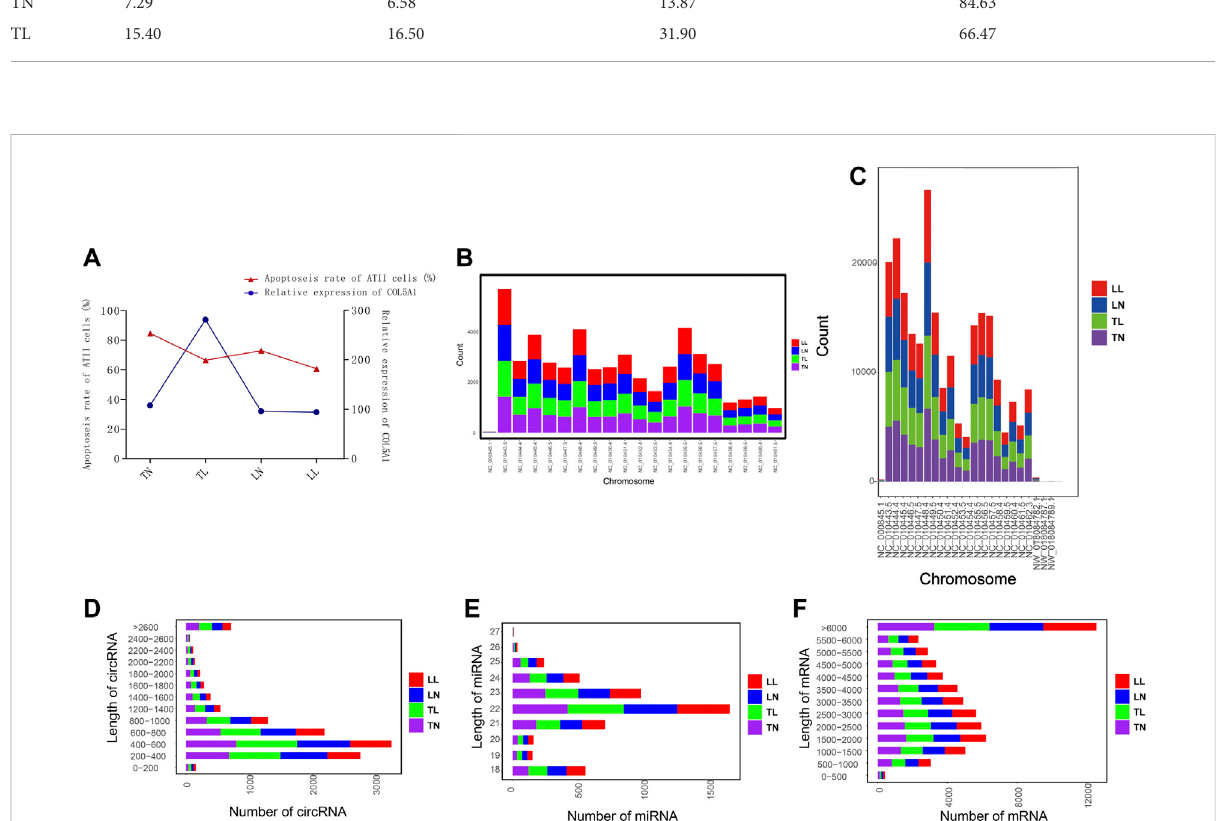
FIGURE 1 General featuresofcircRNAs,miRNAs,and mRNAs. (A) Correlation analysisofCOL5A1and cell apoptosis. (B) Chromosome distribution map of circRNAs. (C) Chromosome distribution map of mRNAs. (D – F) Length distributions for the identi fi ed circRNAs, miRNAs, and